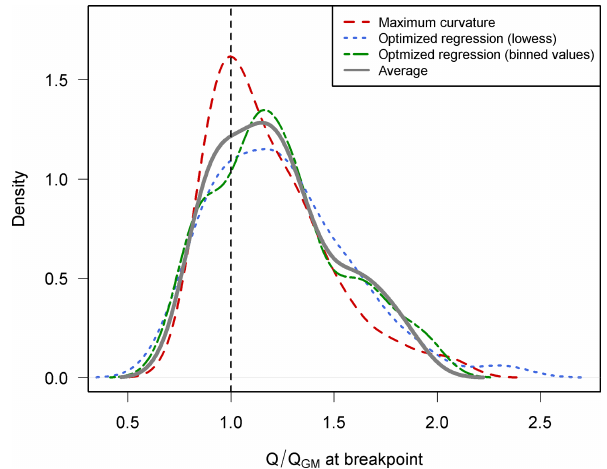
Figure 4. Density distribution of rating breaks ( Q br ) derived from the scaling analysis of the suspended sediment concentration. For detailed results, see also Table